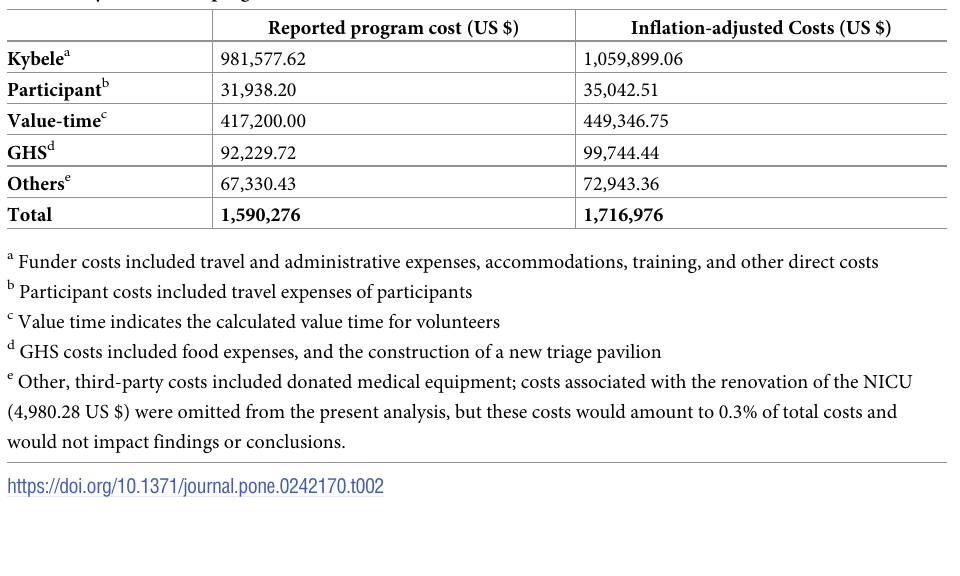
Table 2. Kybele-MEBCI program cost in US